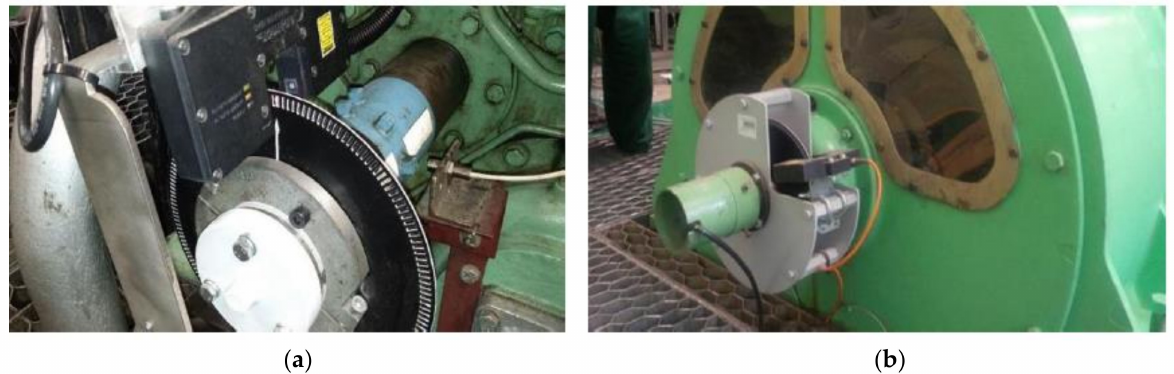
Figure 15. ETNP-10 laser heads installed on both ends of the shaft: ( a ) view from the engine side; ( b ) view from the generator side